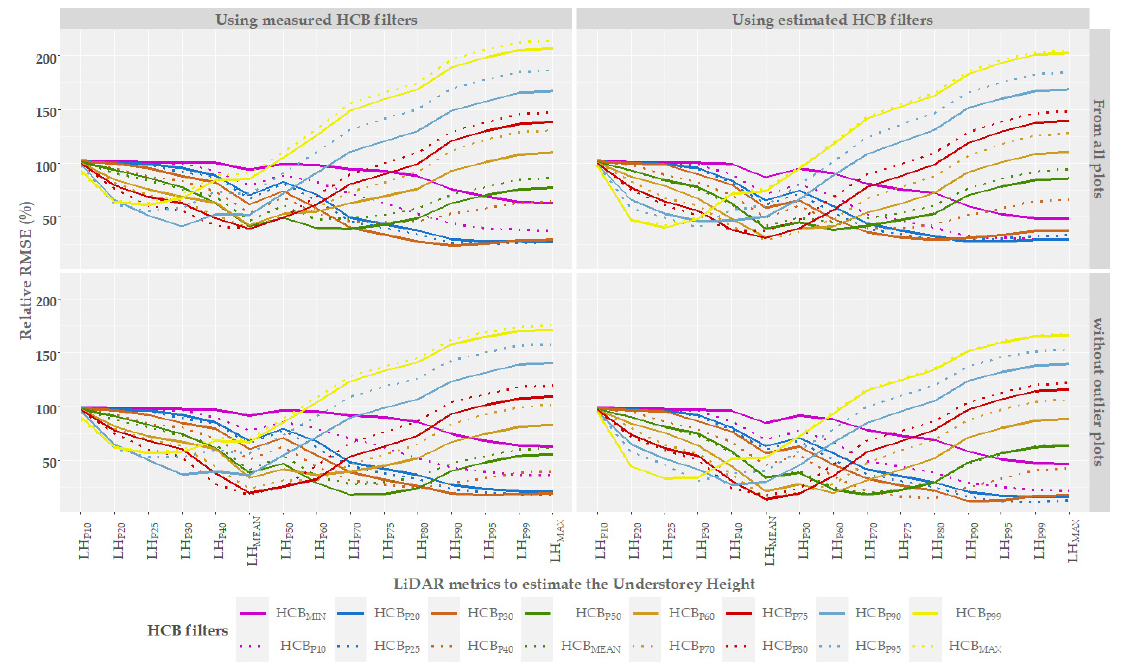
Figure 4. Results of estimated UH: relative RMSE (%) (y axis) for HCB models (filters applied) and for each metric appraised (x axis) using all plots and a sample without outlier plots (rows in facet grid figure) and measured/estimated HCB models (columns in facet grid figure). Note: The complete set of metrics in UH evaluation and their errors are included in Supplementary Materials—Table S1.